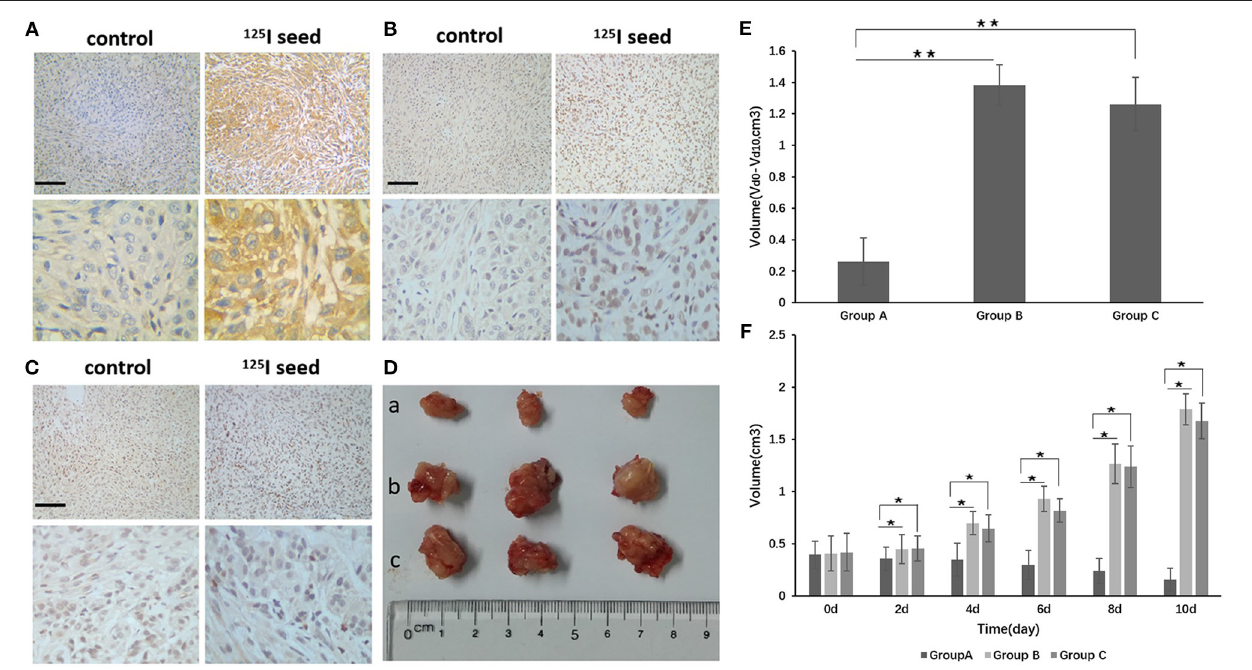
FIGURE 5 | (D) After implantation of the 125 I seed for 10 days, the tumor was removed and the tumor was measured (a group: 125 I seed group, b group: control group, c group: non-activity 125 I seed group). (E) The Vd0-d10 of group A was obviously reduced compared with groups B and C. Vd0-d10 : The change in volume between d0 and d10. (F) There were differences in the volume changes between groups A and B and between groups A and C at 2, 4, 6, 8, and 10 days. The differences between each group are statistically significant (** P < 0.01). Tumor tissue immunohistochemistry found that p-p38 and p-p53, and the apoptotic body expression were upregulated in the 125 I seed group, but p-MDM2 expression was downregulated compared with the control group and the non-activity seed group [ (A) p-p38, (B) p-p53, (C) p-MDM2]. The original magnification is 200. The bar length represents 50 µ m. * P <